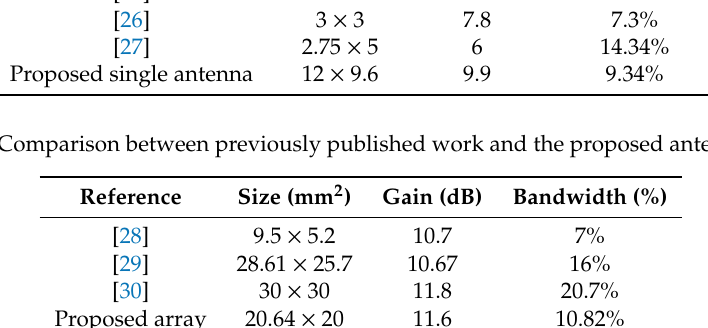
Figure 17. Surface current distribution of the proposed mmWave antenna array ( a ) Top view; ( b ) Bottom view.